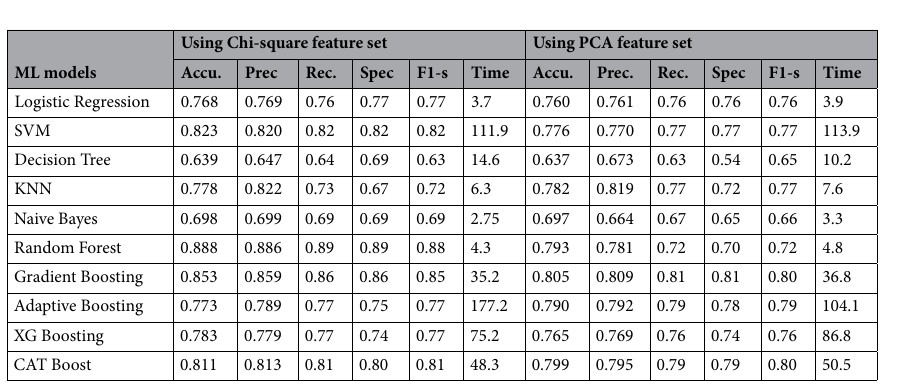
Figure 3. USG scans with image processing steps.